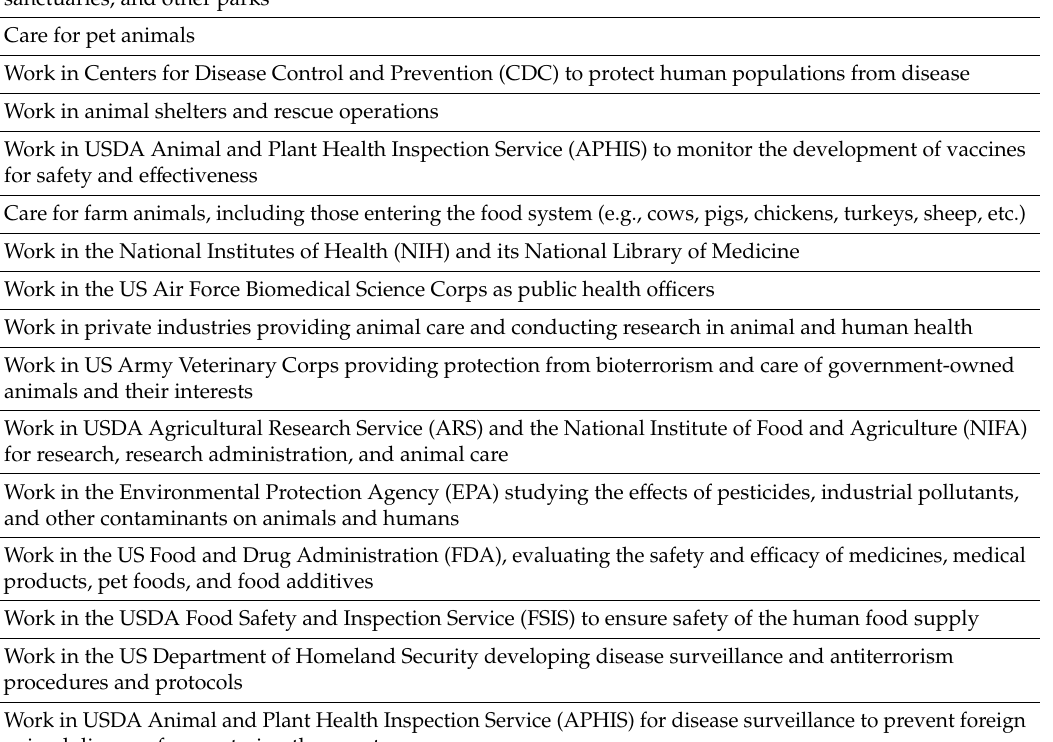
Table 1. Roles of veterinarians in the U.S. identified from American Veterinary Medicine Association (AVMA) publicly available